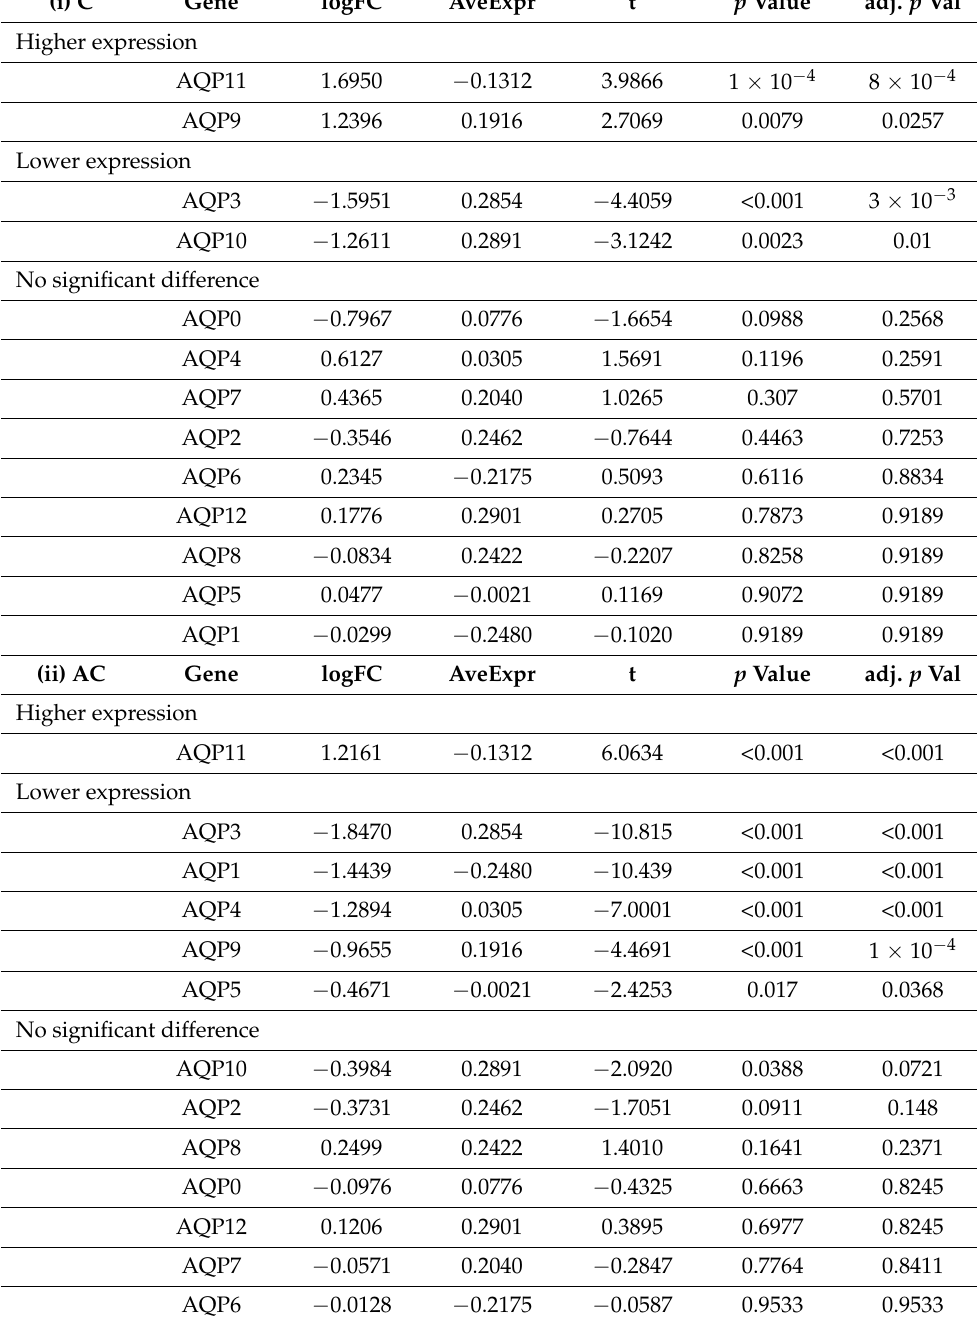
Table 3. Ratios of quantified AQP transcript levels in parietal cortex as compared to the hippocampal formation differ with age. The average expression (AveExpr) levels were determined by averaging the RNAseq levels for all probes used for a given gene. t -values represent the test statistic generated by a comparison of the means using two-sample t -tests, with positive values indicating a larger average value for the RNAseq level in the parietal cortex region as compared to the hippocampus. P values were adjusted (Adj P) for multiple tests using the Bonferroni correction, with significant differences indicated by p <